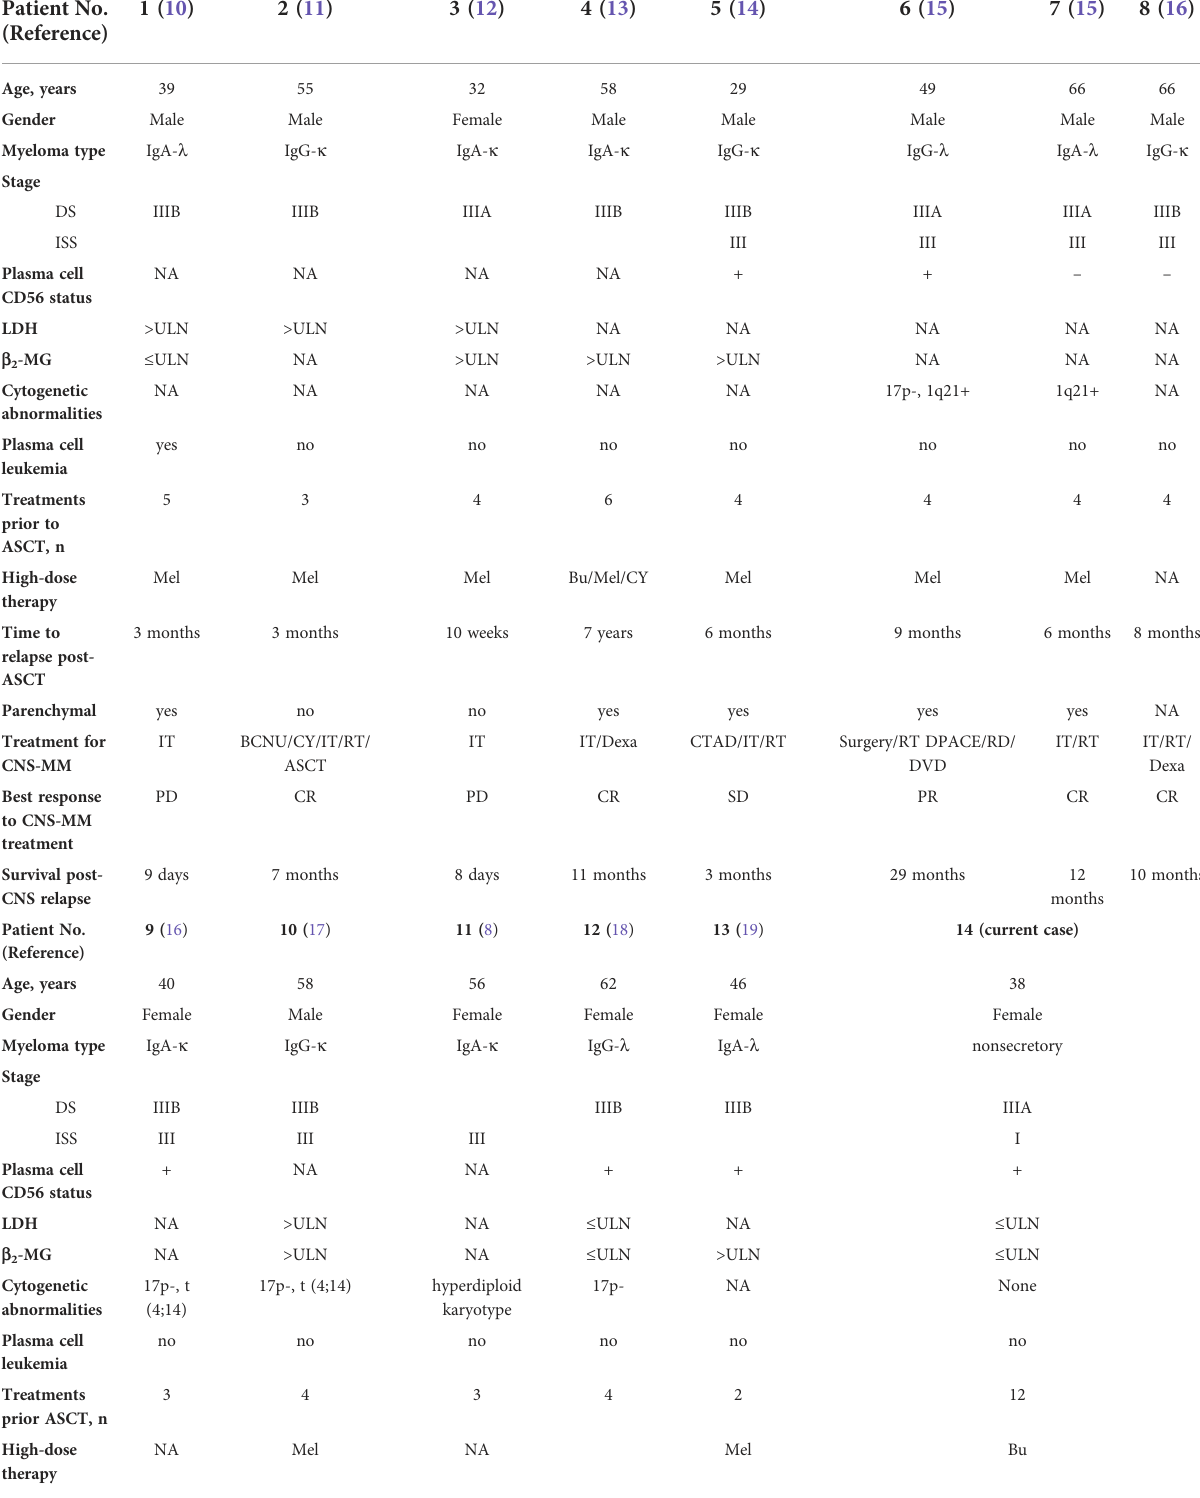
TABLE 1 Published case reports of patients with multiple myeloma who had isolated CNS relapse after ASCT. Patient No.